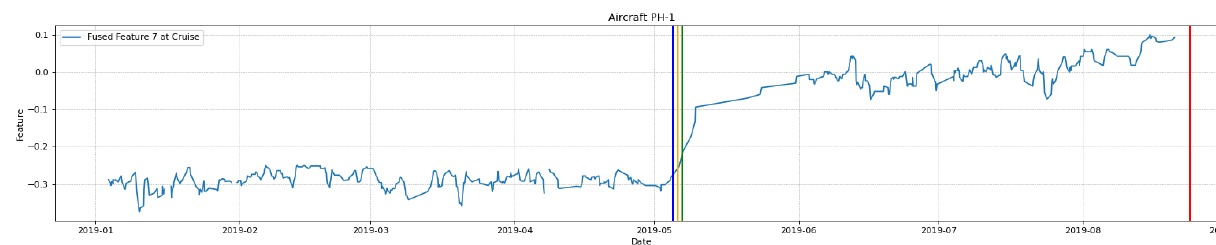
Figure 9. Fused feature 1 at Cruise of aircraft 1.